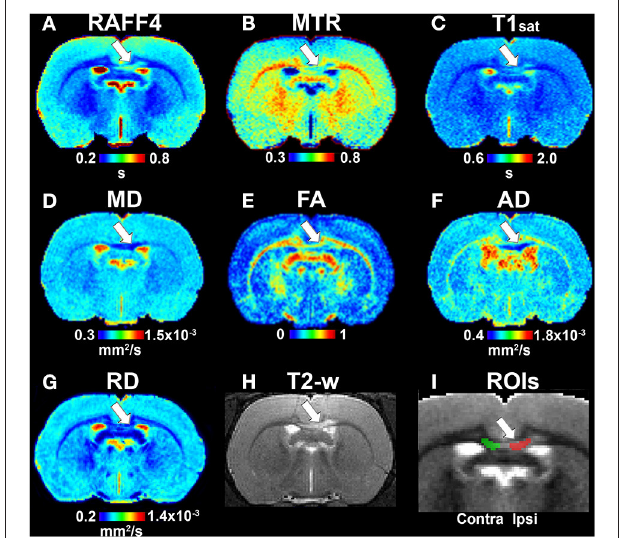
FIGURE 4 | Quantitative MRI maps in the remyelination phase, on day 38. Relaxation time constant map of RAFF4 (A) , magnetization transfer ratio, MTR (B) , T1sat (C) , mean diffusivity, MD (D) , fractional anisotropy, FA (E) , axial diffusivity, AD (F) , radial diffusivity, RD (G) , T2w image with the lesion (H) and a representative example of ROIs for analyzing lesion on a grayscale RAFF4 map (I) . White arrow points to the lesion in the corpus